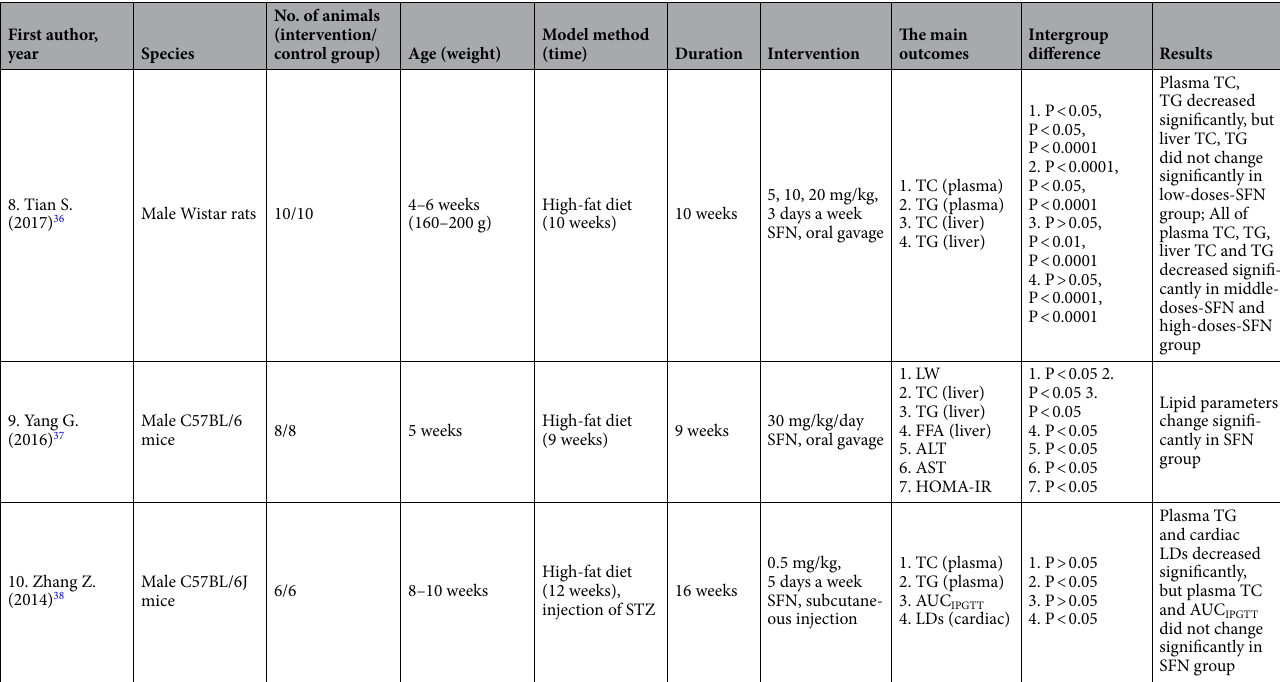
Table 1. Description of included studies. ALT alanine aminotransferase, AST aspartate aminotransferase, AUC area under the curve, FFA free fatty acids, GTT glucose tolerance test, HOMA-IR an index of insulin resistance,